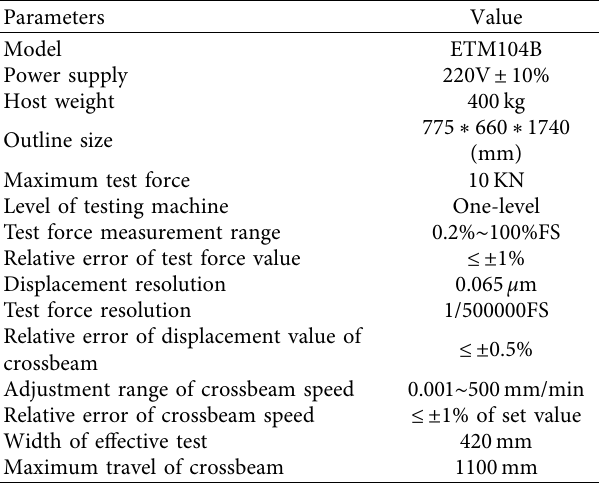
Table 3: Parameters of the ETM-C electronic universal testing